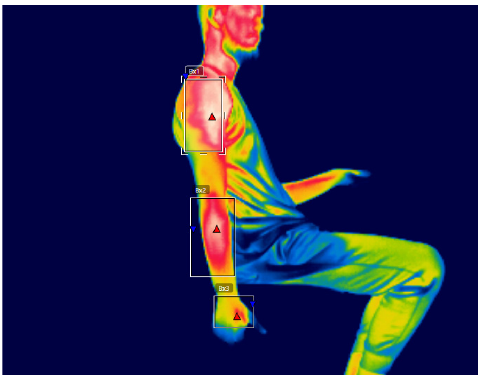
Figure 2. Indication of the regions of interest analyzed, shown in a male participant, after performing one of the experiments of the study for 20 min.